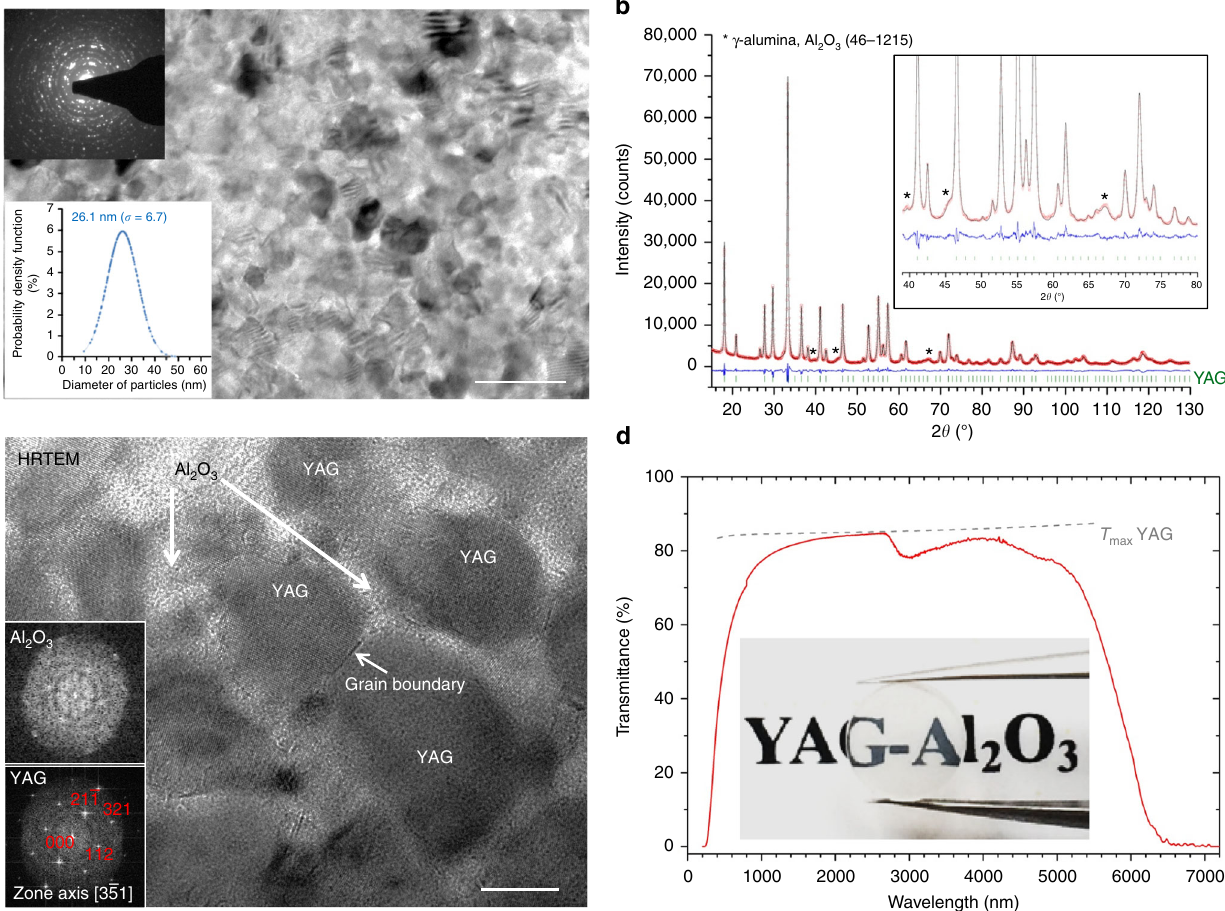
Fig. 1 Transparent YAG-Al 2 O 3 composite nanoceramics. a Bright fi eld TEM micrograph showing the nanometer-scale microstructure of the fully crystallized material (scale bar corresponds to 100 nm). The selected area electron diffraction pattern shows the crystallinity of the sample with both YAG and Al 2 O 3 re fl ections. The size distribution with standard deviation ( σ ) of the YAG crystals is also embedded. b X-ray diffraction of the YAG-Al 2 O 3 ceramic crystallized from a 26 Y 2 O 3 – 74 Al 2 O 3 glass via a simple 2 h heat treatment at 1100 ℃ in air. The Rietveld re fi nement leads to a 79±2 wt% content of YAG (21±2 wt% of γ -Al 2 O 3 ). c HRTEM micrograph of the YAG-Al 2 O 3 ceramic showing the presence of two crystalline phases: thin Al 2 O 3 areas surrounding YAG nanograins sharing grain boundaries (scale bar corresponds to 20 nm). The related FFT patterns are embedded. d Transmission spectra in UV – VIS – NIR and MIR region of the YAG-Al 2 O 3 ceramic measured through a 1.5 mm thick sample. The dashed gray line corresponds to the theoretical maximum transmission of YAG[53] (the refractive index of YAG single crystal and YAG-Al 2 O 3 ceramic at 589 nm is 1.82 and 1.77, respectively). The photograph of the YAG-Al 2 O 3 ceramic sample (diameter = 4.5 mm) placed 2 cm above the text is